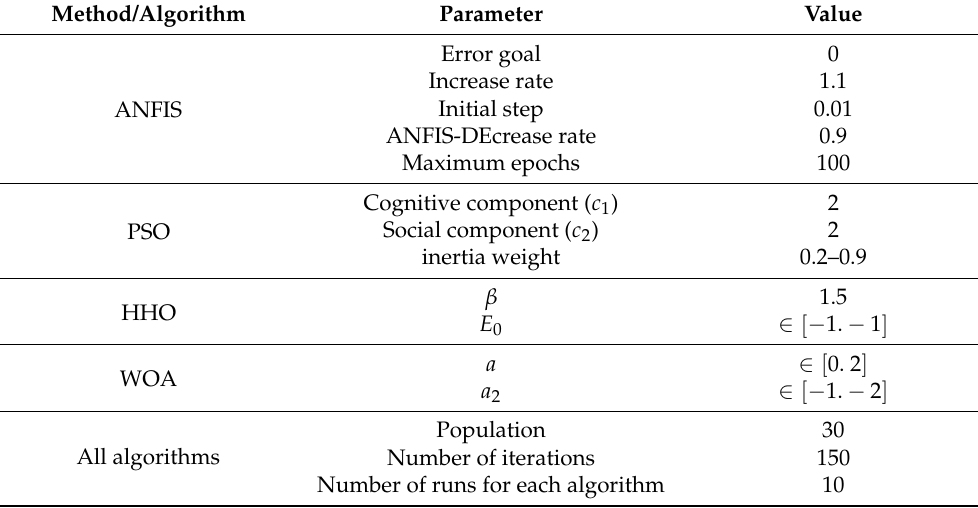
Table 3. Parameter settings of ANFIS and three optimization algorithms used in this